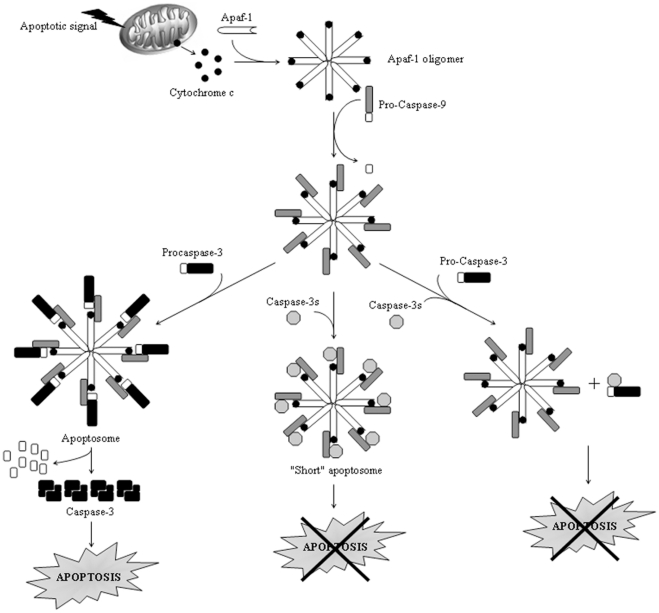
Model of apoptosis inhibition by caspase-3s.After apoptotic signal, cytochrome c is released from mitochondria to the cytoplasm. Then, Apaf-1/cytochrome c oligomers are formed and interact with caspase-9. In presence of procaspase-3 only, the complex Apaf-1/cytochrome c/active caspase-9 interacts with procaspase-3 to form the complete apoptosome. Then, active caspase-3 is release from the complex and apoptosis occurs. In presence of caspase-3s, the complex Apaf-1/cytochrome c/active caspase-9 interacts with caspase-3s to form a “short” apoptosome having not the ability to induce apoptosis. Finally, in presence of both procaspase-3 and caspase-3s, caspase3s interacts with procaspase-3. This interaction induces the sequestration of procaspase-3, inhibiting the complete apoptosome assembly.